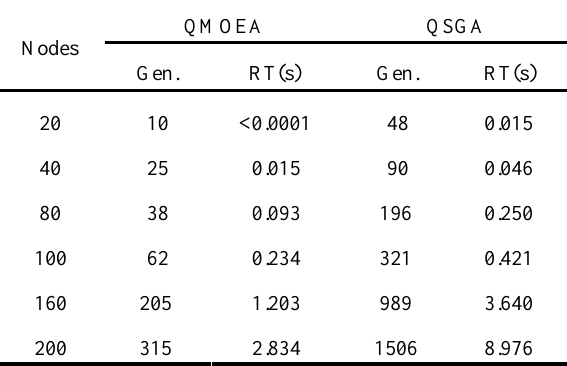
Table 1 convergence speed of QMOEAand QSGA QMOEA QSGA Nodes